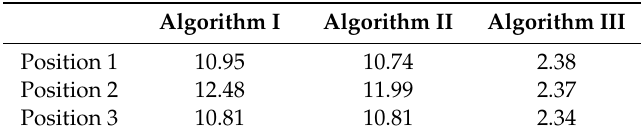
Table 1. Dynamic Time Warping (DTW) distance of Algorithm I, II, and III processed results with standard input signals.